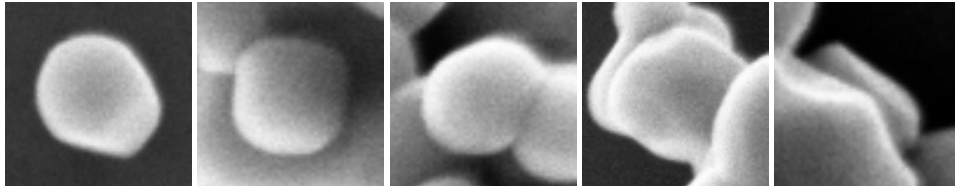
Figure 9. TiO 2 particles in different configuration: isolated, complete, touch complete, masked and unusable (from left to right